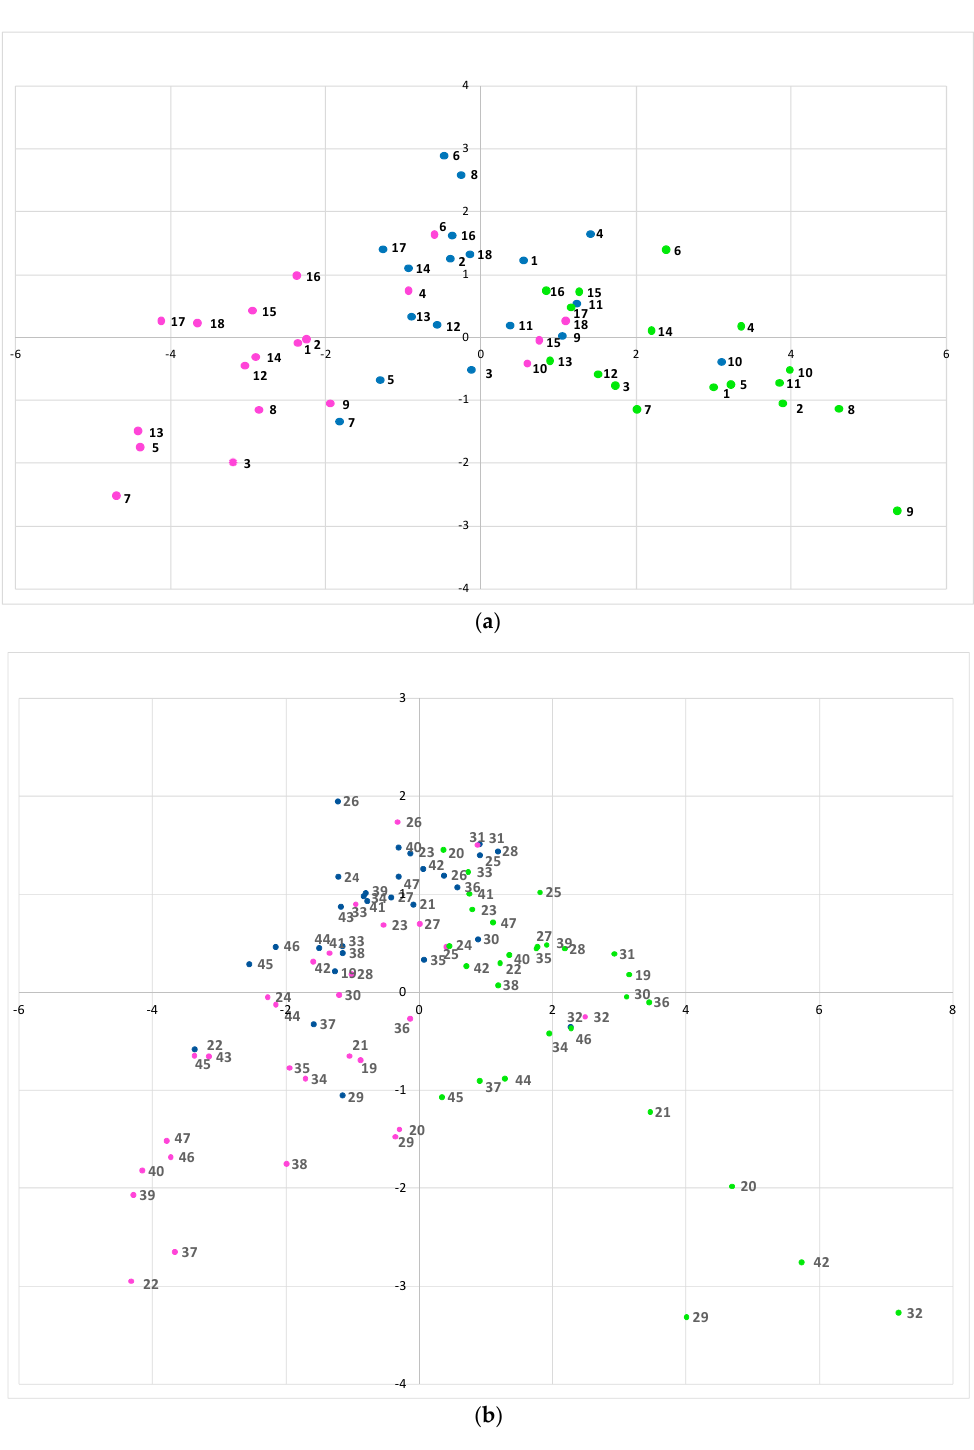
Figure 3. Scatter plot of the PCA scores. Plants treated for two ( a ) or three weeks ( b ); control (green), water deficit (pink) and salt stress (blue) treatments. ( a ) 1–9, cultivars from Spain; 10–15, from Colombia and 16–18, from Cuba and ( b ) 19–32, cultivars from Spain; 33–45, from Colombia and 46 and 47 from Cuba.